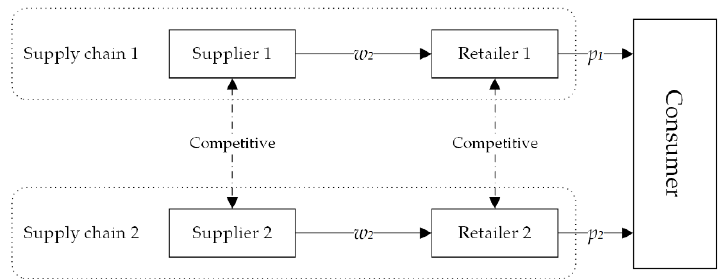
Figure 2. Competitive supply chain model.